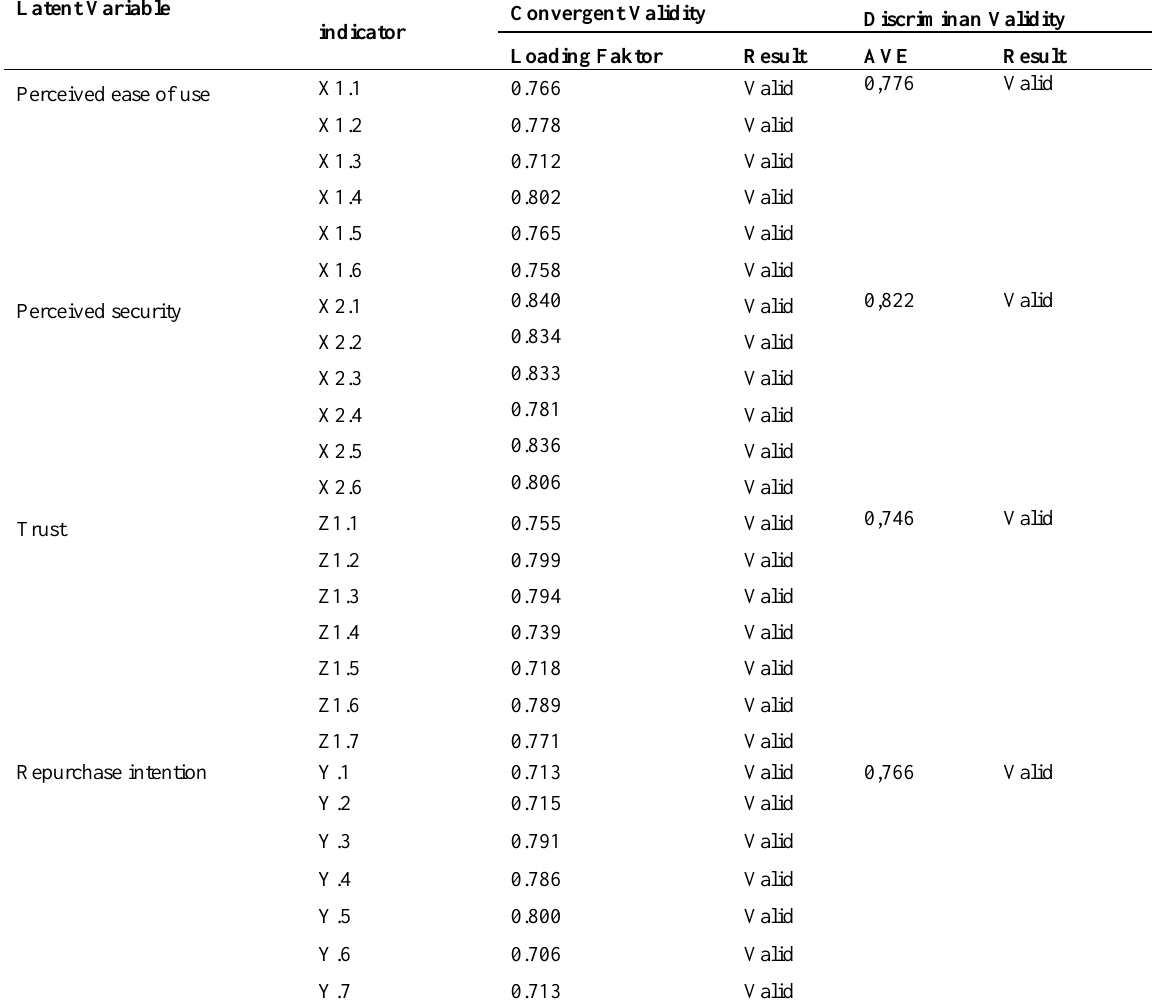
Table 3 : Validity